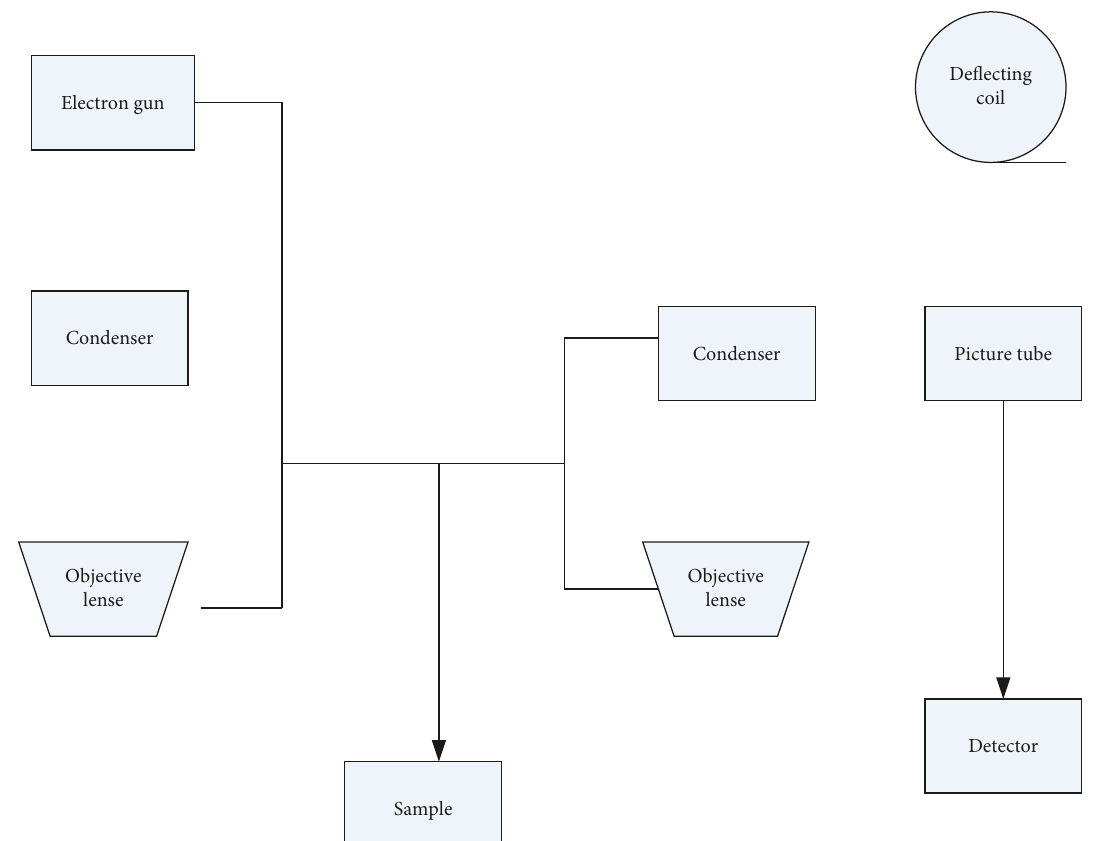
Figure 7: Schematic diagram of the scanning electron